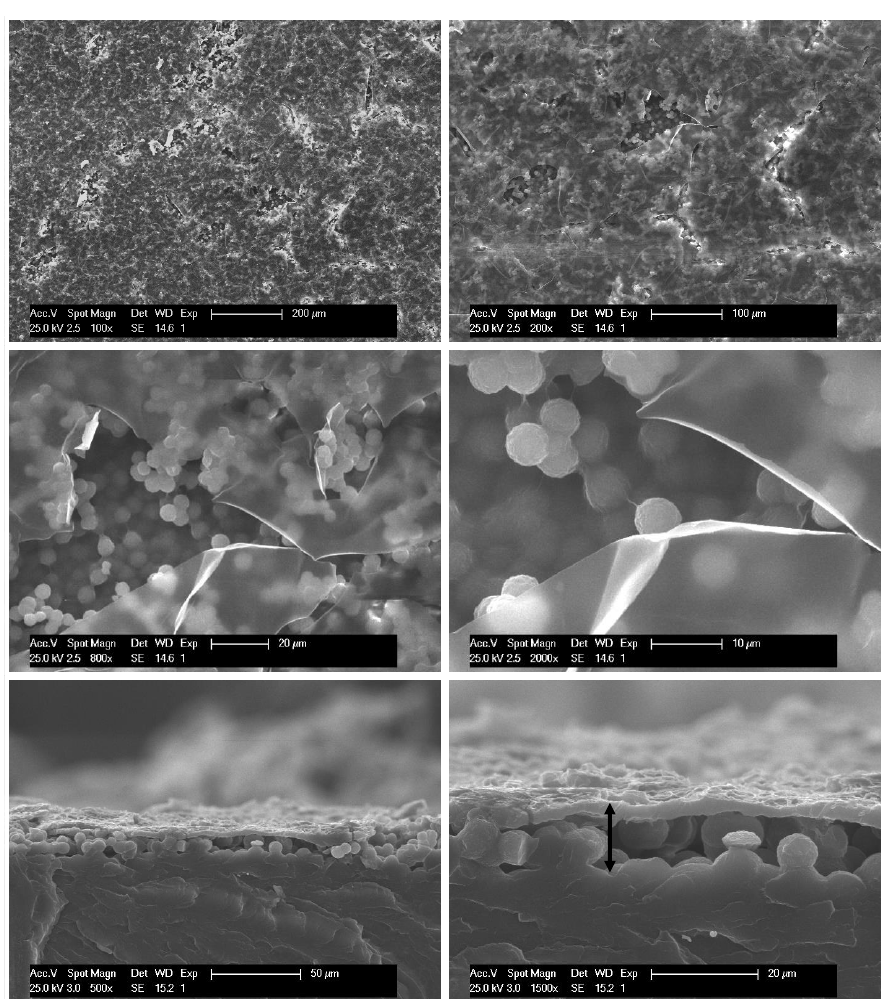
Figure 4. SEM images of Q-PET-D surface at 100×, 200×, 800× and 2000× and section at 500× and 1500× magnification. SEM images of the sample after 1-h immersion in DCM show the occurrence of a are distributed all along the film surface. These particles do not have a smooth surface; instead, a submicrometer roughness is suspected at the highest magnifications. Attending to the section images, it can be concluded that such particle layer has a thickness of about 8 – 12 µm, whereas the rest of the film remains dense. Interestingly, this particle layer is covered by a thin and continuous layer that is cracked at some points, showing the parti- cles below. The origin of this layer has not been explained yet. A hypothesis is that short and mobile chains diffuse out of the particulate structure and form this skin. In any case, the efforts at this point focused on removing that skin layer in order to leave the particle layer fully exposed. For the removal of this continuous skin, two procedures were tried. On the one hand, the skin was mechanically removed by pushing it away with acetone spraying at room temperature. This procedure will be named as A in what follows. It is worth mentioning that air spraying was unsuccessfully attempted. On the other hand, the PET skin was dis- solved by immersion in a 20% NaOH solution (procedure N). This last treatment might